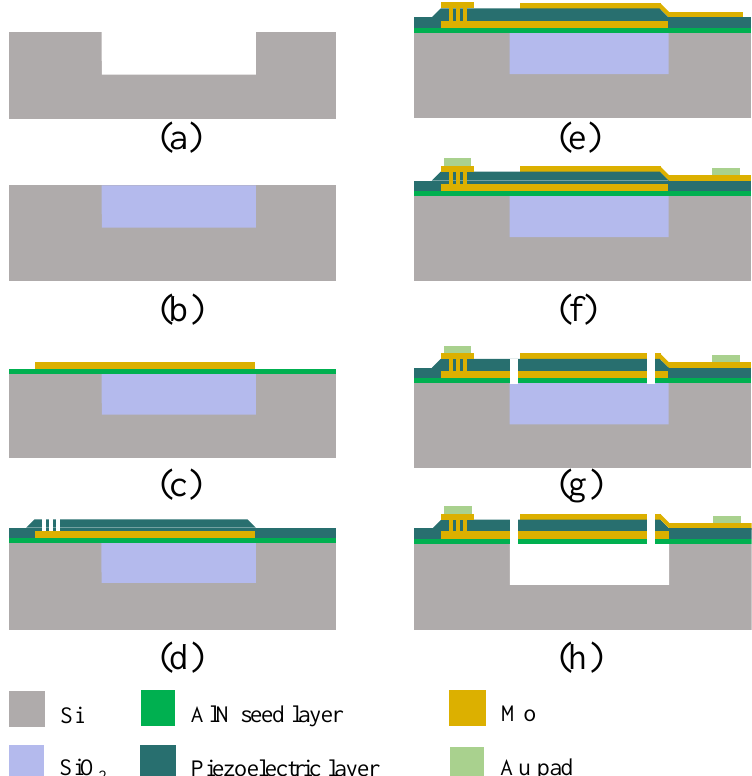
Figure 1. Main fabrication process steps of FBAR devices. ( a ) Etching Si substrate to form the cavity. ( b ) SiO 2 sacrificial layer deposition and polished. ( c ) AlN seed layer and bottom Mo electrode deposition. ( d ) Piezoelectric layer deposition and etched. ( e ) Top Mo electrode deposition and patterned. ( f ) Au pad layer deposition. ( g ) Release windows opened. ( h ) Releasing SiO 2 sacrificial layer to form the cavity.